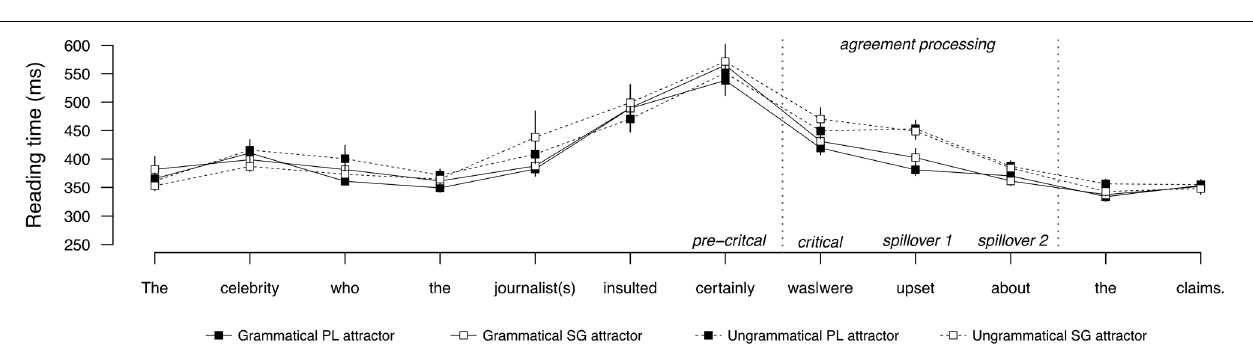
FIGURE 3 | Word-by-word reading times for the direct object attractor conditions in Experiment 2. Error bars indicate standard error of the mean.